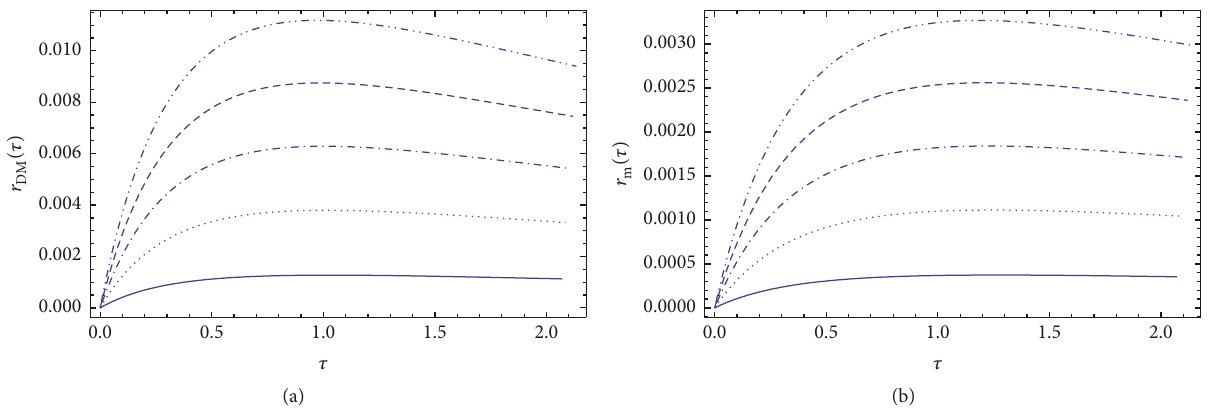
Figure 1: Time variation of the dark matter energy density (a) and of the radiation (b) during the reheating period in the presence of a large- field polynomial potential, for different values 𝛼 𝜙 of the decay width of the scalar field: 𝛼 𝜙 = 0.01 (solid curve), 𝛼 𝜙 = 0.03 (dotted curve), 𝛼 = 0.05 (dash dotted curve), 𝛼 = 0.07 (dashed curve), and 𝛼 = 0.09 (dash double dotted curve), respectively. For 𝑝 we have adopted the 𝜙 𝜙 𝜙 value 𝑝 = 1.8 , while 𝜇 = 3.5 . The initial conditions used to numerically integrate (92) are 𝜙(0) = 1.1 , 𝑢(0) = −1 , 𝑁 𝜙 (0) = 3 , 𝑟 DM (0) = 0 , and 𝑟 (0) = 0 , respectively. m